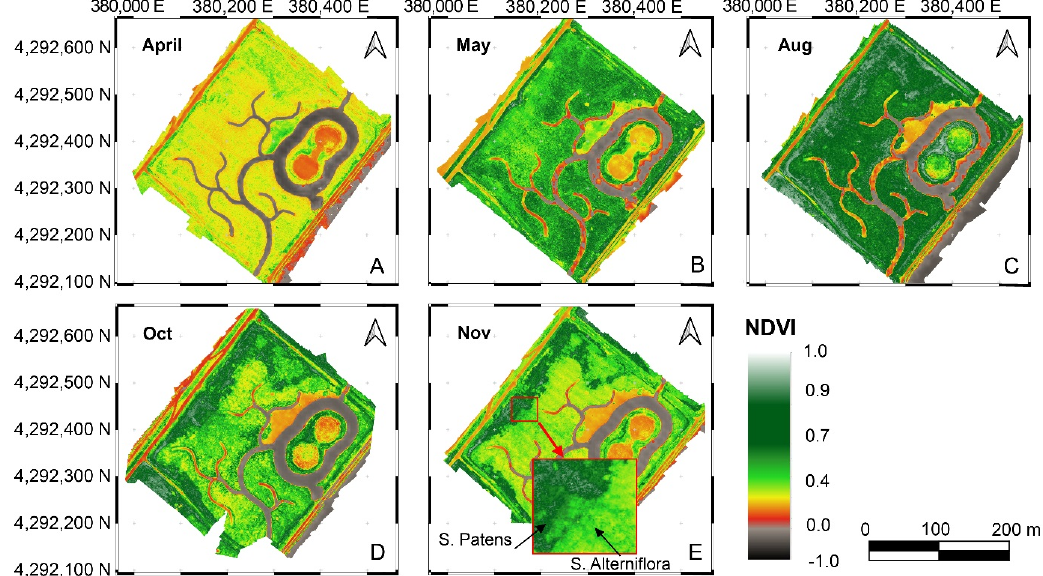
Figure 7. NDVI for Cell 1B in the five months surveyed, ( A ) April 2019, ( B ) May 2019, ( C ) August 2019, ( D ) October 2019 and ( E ) November 2019. Inset in November image shows area where S. alterniflora is migrating into the original high marsh zone.